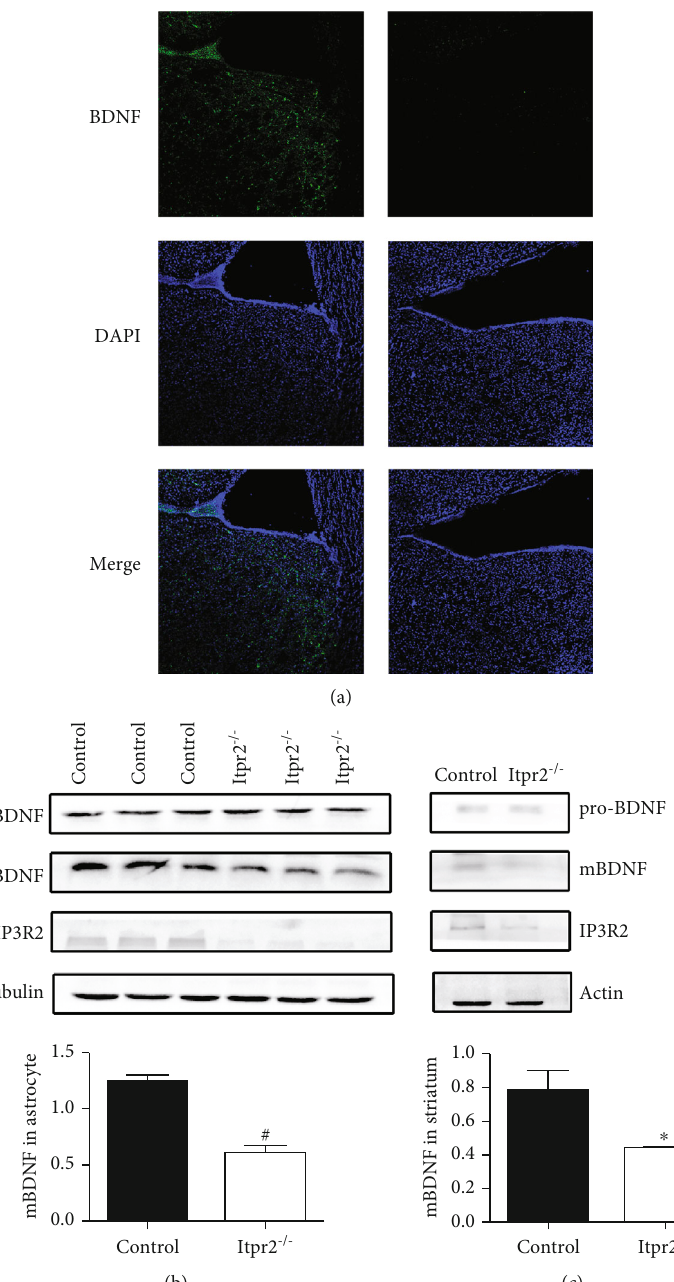
Figure 4: Detection of BDNF level in Itpr2 -/- samples and controls. (a) BDNF immuno fl uorescence staining and expression in the striatum ( × 100). (b) Analysis of BDNF expression in the striatum by Western blotting. (c) Analysis of BDNF expression in C8-D1A by Western blotting. Data are expressed as the mean ± SD . Number sign indicates P < 0 : 01 when compared with the